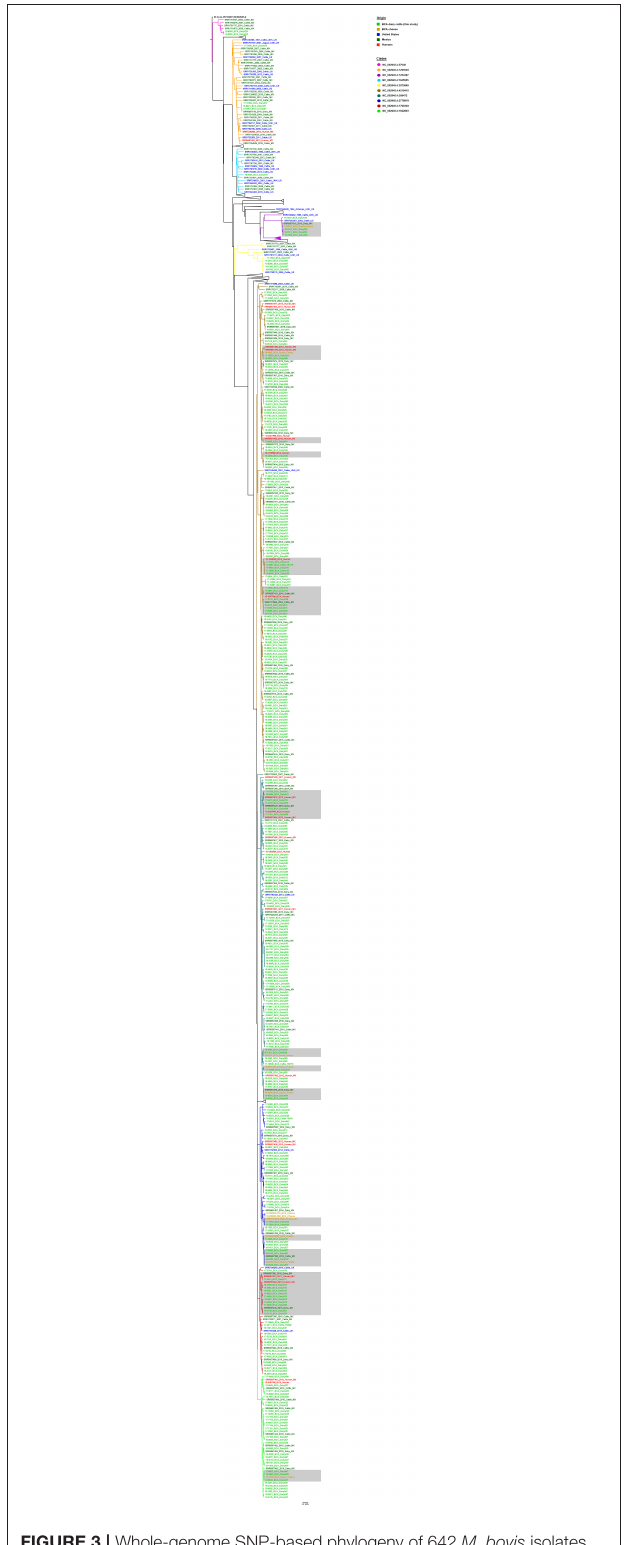
FIGURE 3 | and the US. The BCA isolates from dairy cattle and cheese obtained from this study correspond to 10 main clades, as indicated in the legend. Each clade is labeled according to the genome position of the defining SNP for that clade, with respect to the reference genome M. bovis AF2122/97 (NC002945.4). Gray-shaded areas indicate clusters of human and/or cheese isolates that are within 10 SNPs of a recent common shared ancestor. Some clades (of unrelated isolates to BCA) were collapsed for to improve visibility. The scale bar represents a distance of 40 SNPs (branch length).